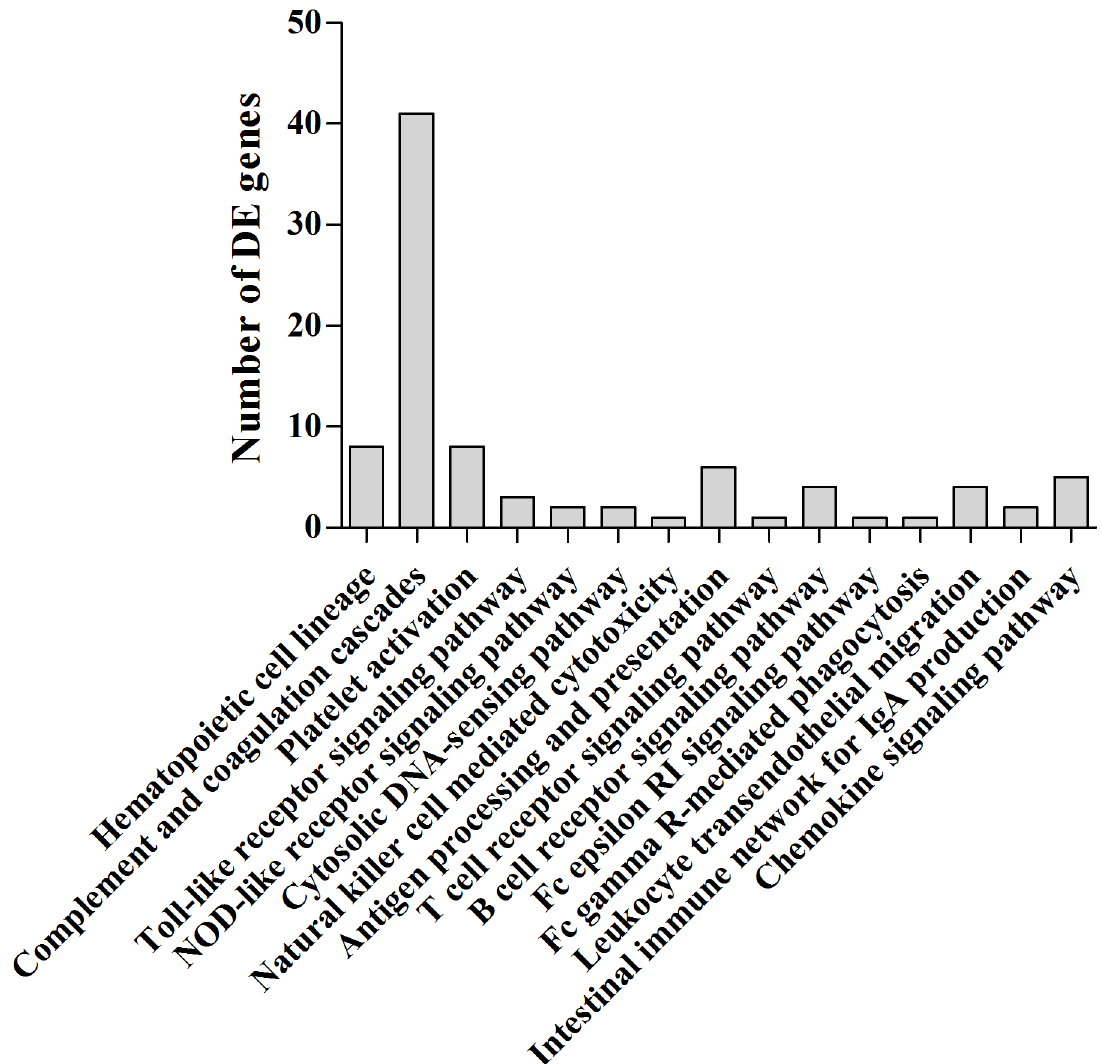
Fig 5. DE genes related to immune